Question: Describe this figure in one sentence.
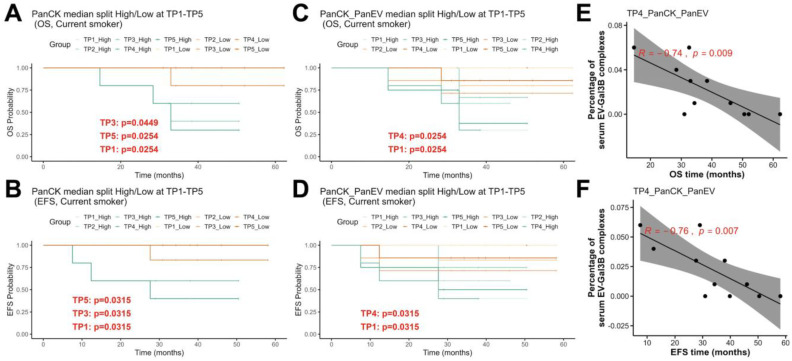
Answer: Prognostic significance of EV-associated markers in active smokers. (A, B) Kaplan–Meier survival analysis of the PanCK + -EXÖBead complex at TP1–5 for EFS and OS. (C, D) . Kaplan–Meier survival analysis of the PanCK + /PanEV + -EXÖBead complex at TP1–5 for EFS and OS. (E, F) Correlation of PanCK + /PanEV + signal on the EV-EXÖBead complex to OS (p = 0.009) and EFS (p = 0.007) at TP4.